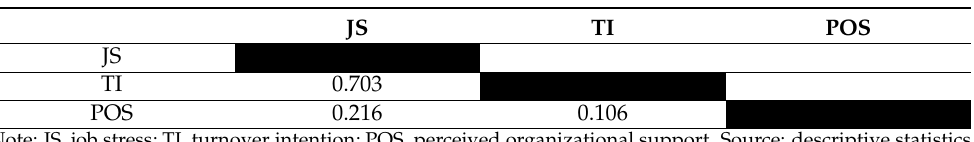
Table 4. The HTMT analysis for discriminant validity.